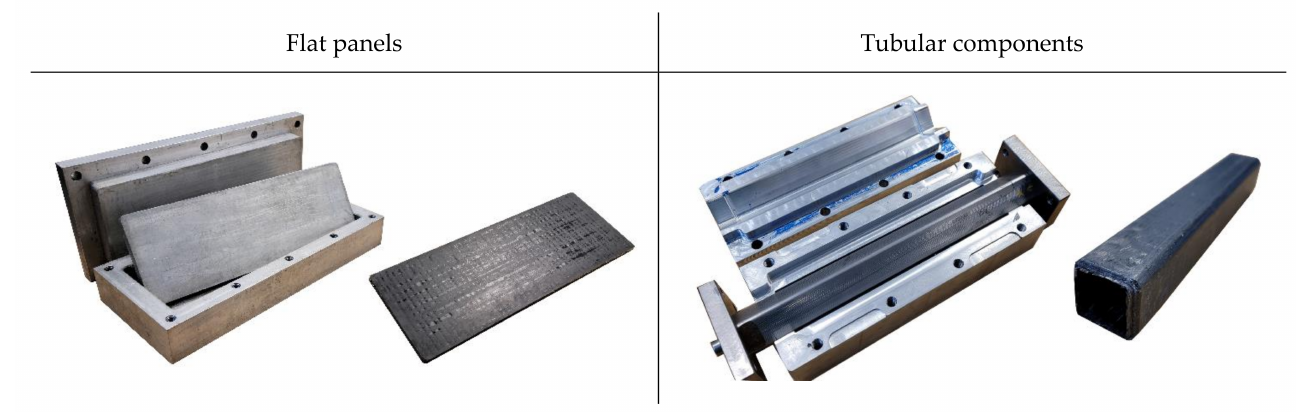
Figure 2. Manufacturing of NCF components: the molds and the processed parts.